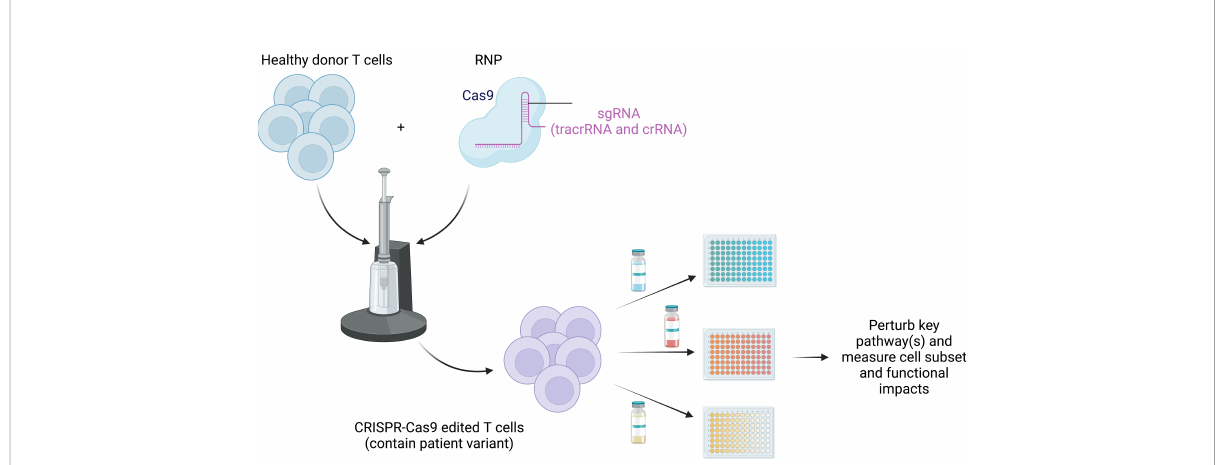
FIGURE 4 Retuning altered pathways to improve function. CRISPR-Cas9 can be used to edit healthy donor primary T cells to match the patient variant to overcome paucity of patient cells, especially those prior to immune-relevant therapy. Testing of treatment options (both preexisting and novel) can be exploited using high-throughput screening strategies to study the impact of blocking and/or stimulating identi fi ed dysfunctional pathways. This will allow us to identify and target common states of dysfunction across monogenic